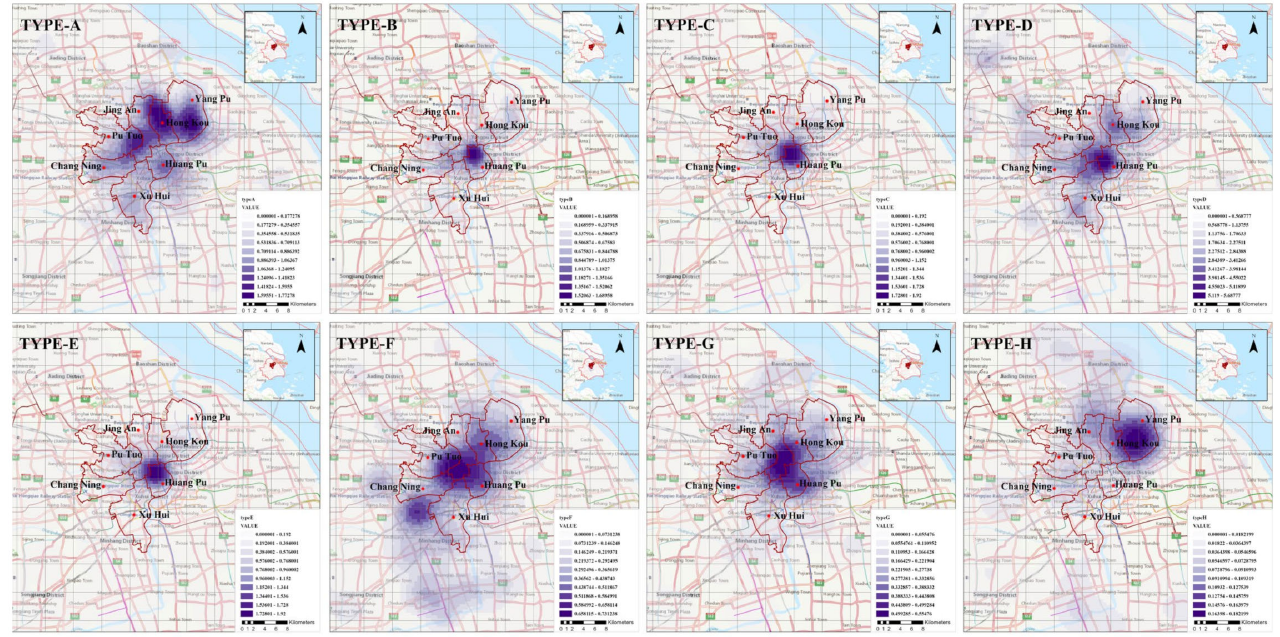
Figure 4. Kernel density diagram of eight types elderly care facilities (Type-A, -B, -C, -D, -E, -F, -G, and